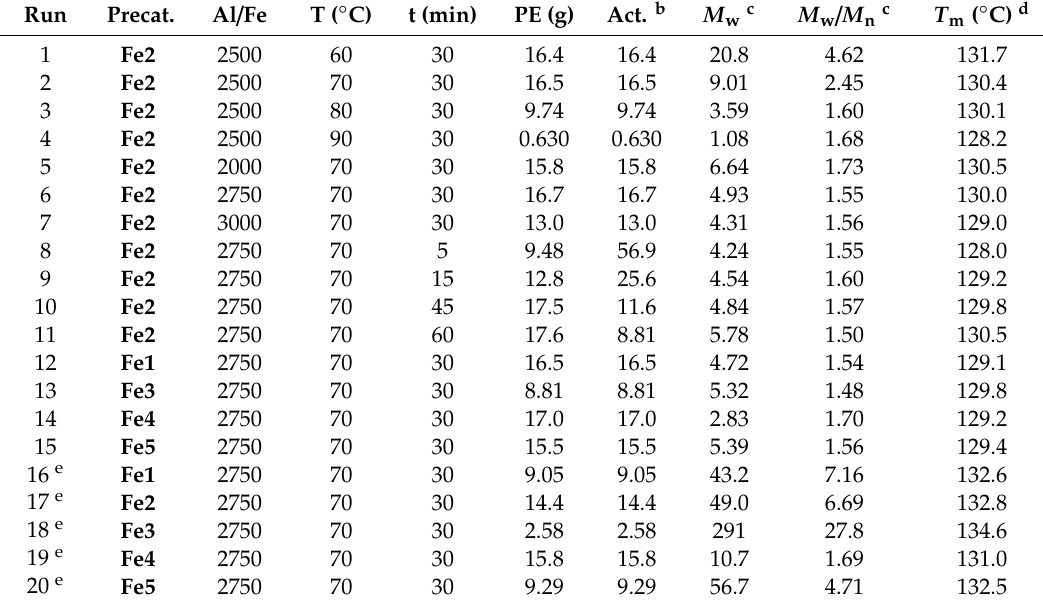
Table 3. Polymerization screening using Fe1 – Fe5 a